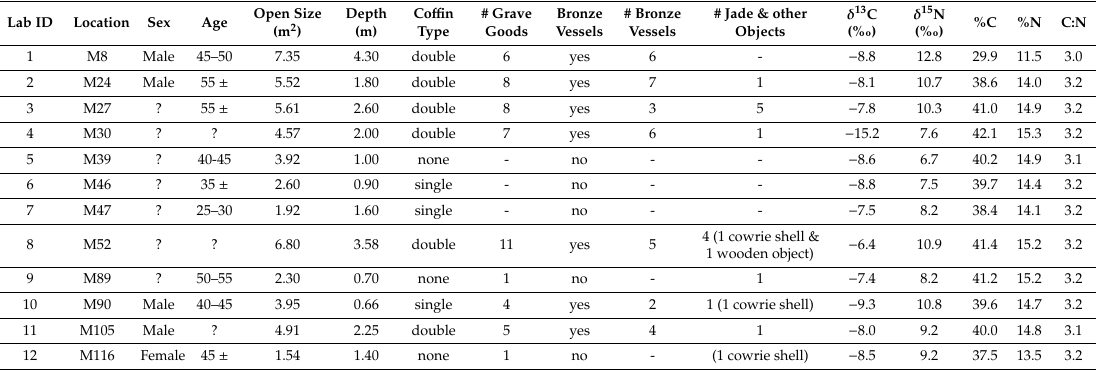
Table 2. Isotopic results and sample information for all humans from the Xiaohucun site, Henan Province, China.